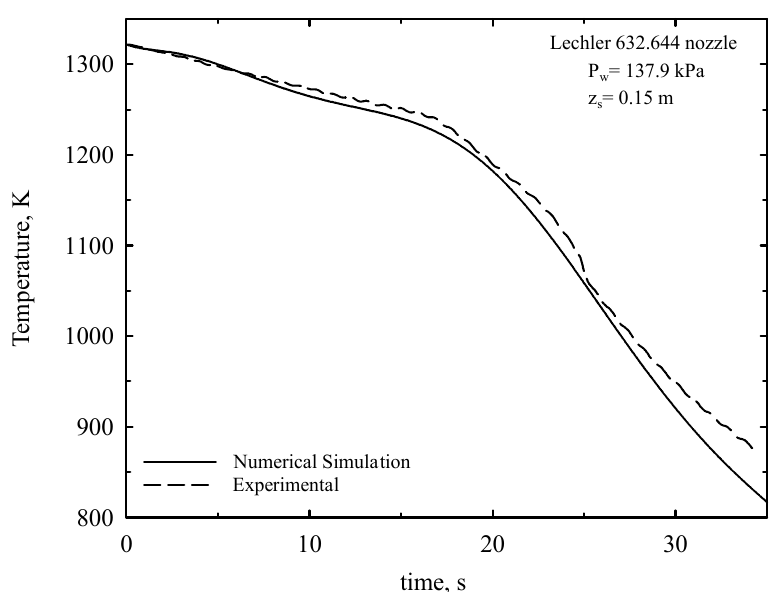
Figure 8. Comparison of numerical simulation with experimental data of the cooling curve.